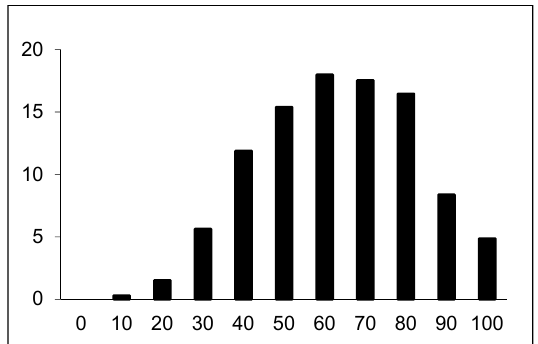
Figure 3 : Student performance in the June